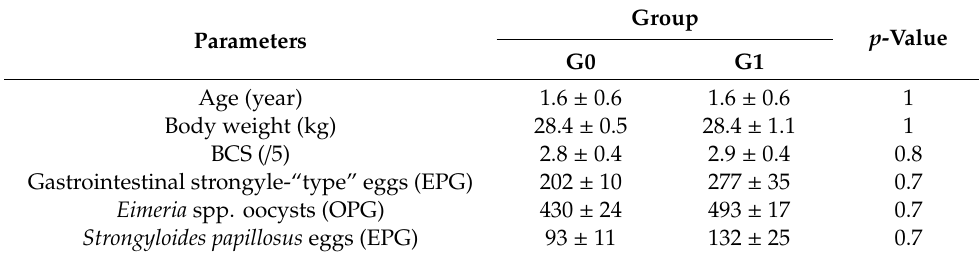
Table 1. Group characteristics according to initial animal parameters (mean ±